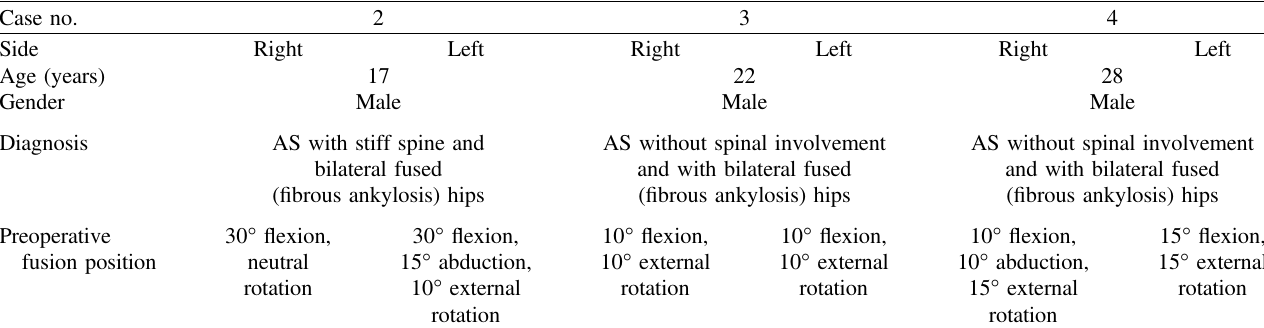
Table 1. Characteristics of cases 2 – 4.